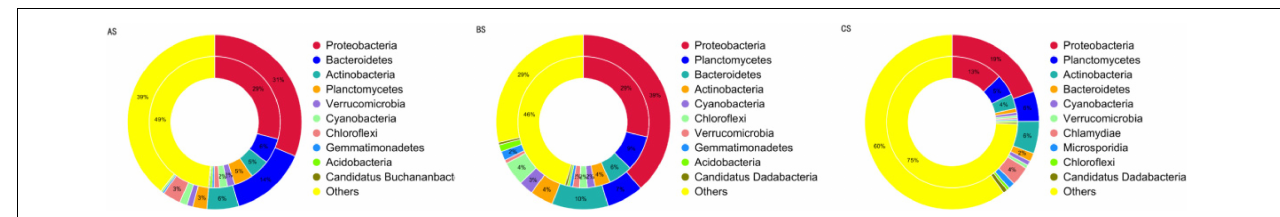
FIGURE 6 | Species identification analysis of AROs in AS, BS, and CS (the inner circle is the species distribution of ARO and the outer circle is the species distribution of all the genes in the group). AS, water sample; BS, biofloc sample; CS, intestinal